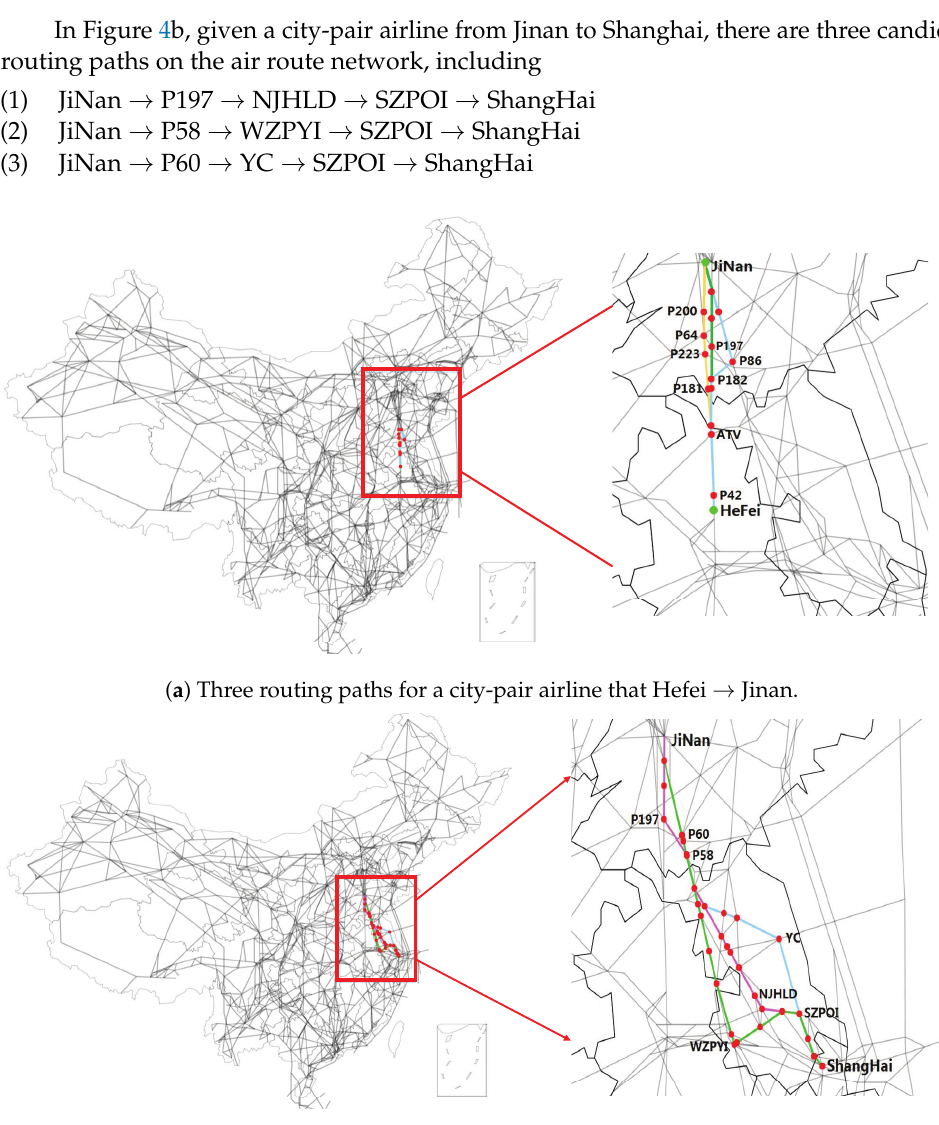
Figure 4. An example of multi-routing paths on air route network for city-pair airlines